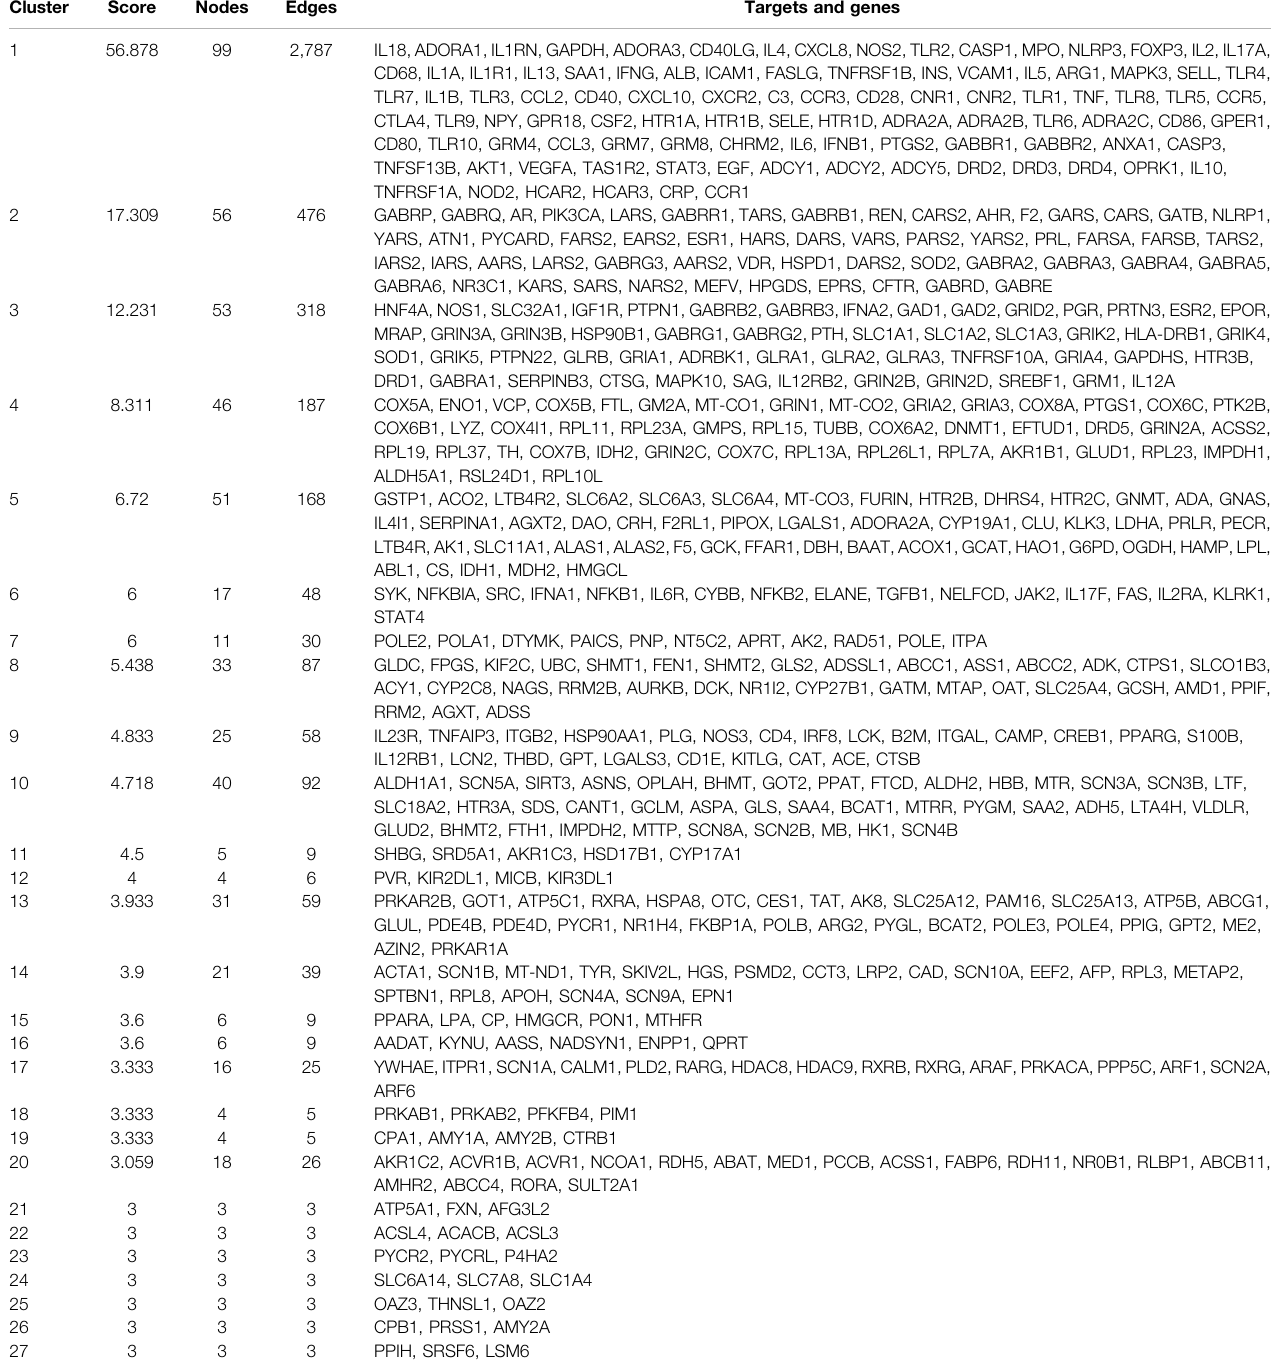
TABLE 1 | Clusters of DGBXD known Target-AS PPI Network. Cluster Targets and